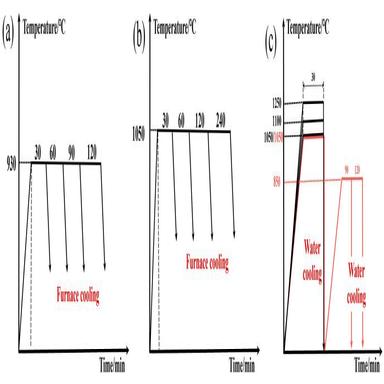
Heat treatment curves for (a) industrial pure iron for ferrite microstructures, (b) 304 austenitic stainless steel for austenite microstructures, (c) 2205 duplex stainless steel for ferrite–austenite microstructures.